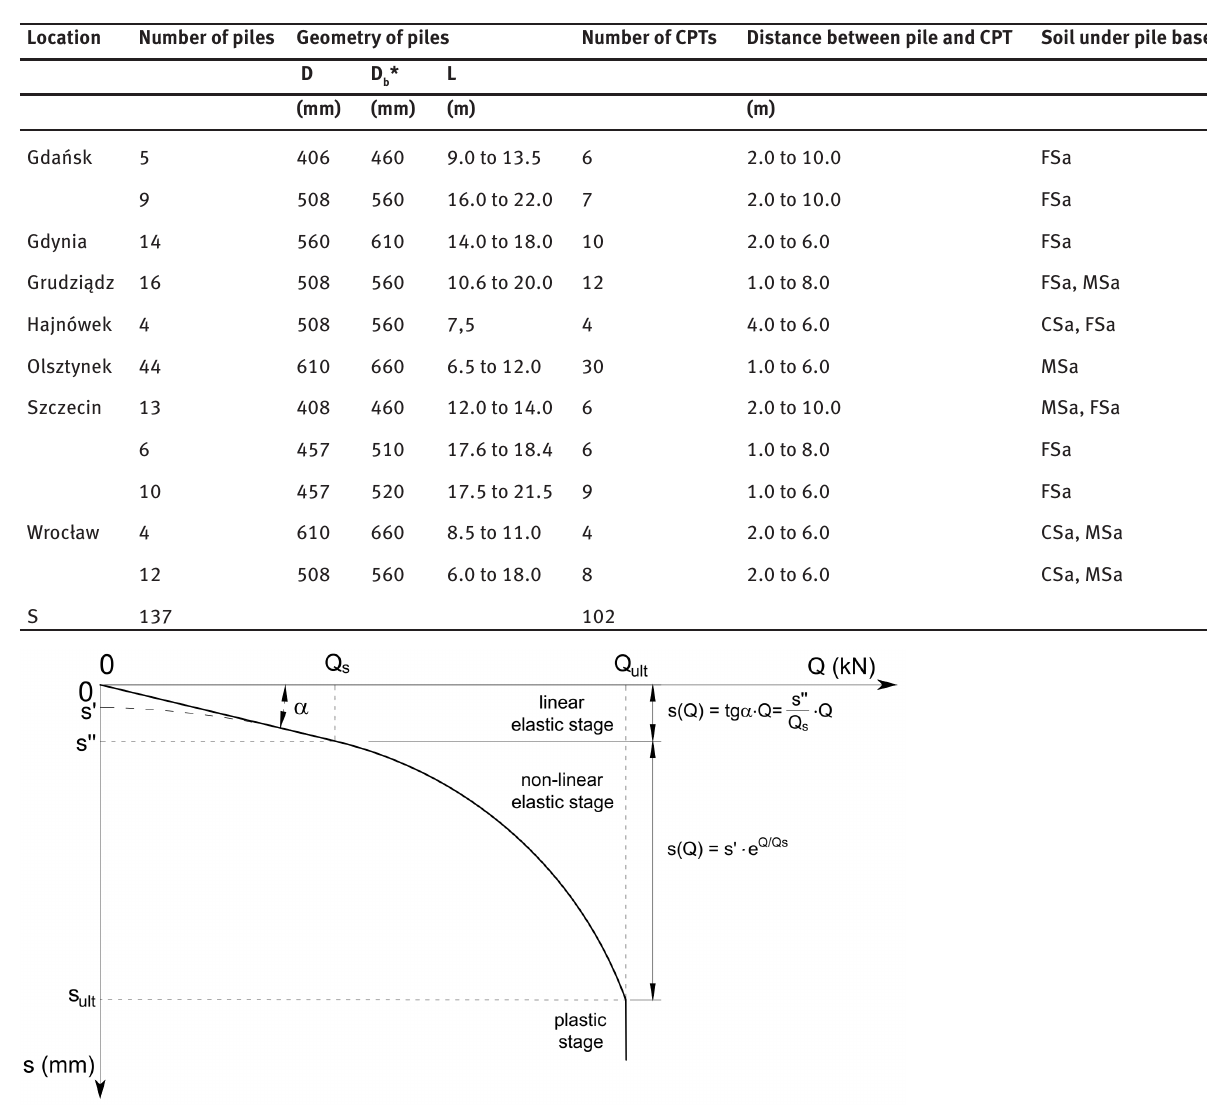
Figure 2: Theoretical model of load–settlement